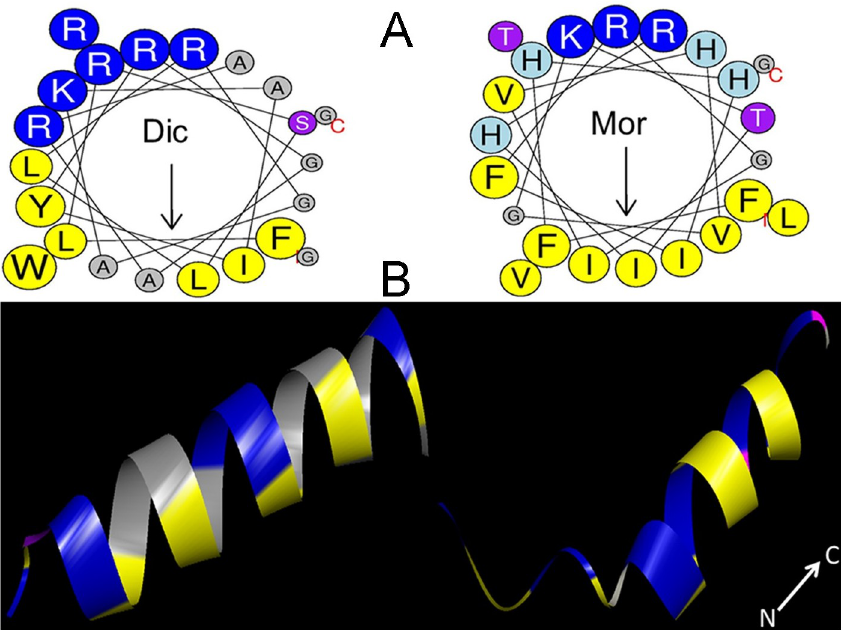
Fig 1. Helical wheel projections and three dimensional molecular modeling of dicentracin-like and moronecidin peptides. (A) The residue numbering starts from the N-terminus. Hydrophobic and positively charged residues are defined with yellow and blue color, respectively. (B) Three dimensional structure of dicentracin-like as predicted by I-TASSER (http://zhanglab.ccmb.med.umich.edu/I-TASSER/) and three dimensional structure of moronecidin with PDB code2 JOS as obtained from protein data bank (https://www.rcsb.org/pdb/home/home.do) and displayed with Discovery studio